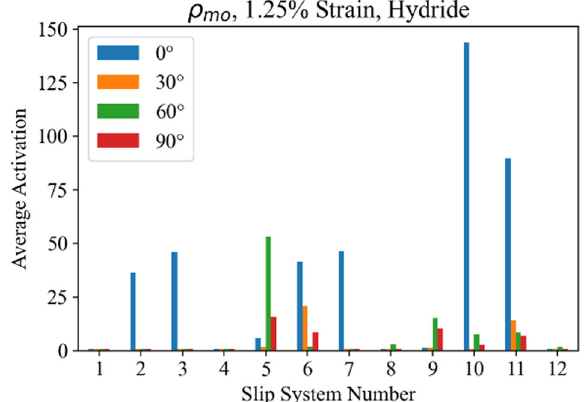
Fig. 18 Average mobile slip system activation for parent material (hcp) at 2.0% nominal strain.